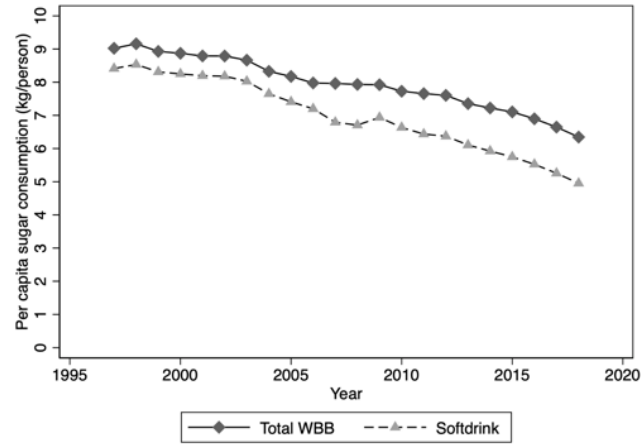
Figure 4. Per capita sugar contribution: Sugar-sweetened water-based beverages and sugar-sweetened carbonated soft drinks. Note: excludes fruit juices and milk.